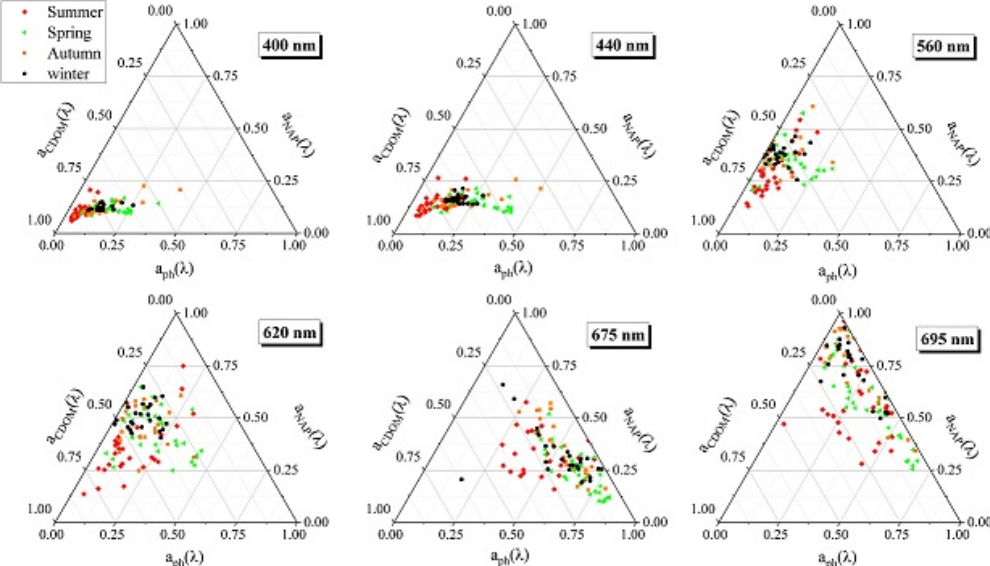
Figure 16. Ternary plots for all samples used in this study at specific wavelengths showing the relative contributions of phytoplankton, NAP and CDOM. The relative proportion of a given absorption component x (scaled in 0 and 1) for a given sample is calculated as x /( x + y + z ) where y and z are the two other components. The plot is triangular in shape because the three components are constrained to sum to 1.